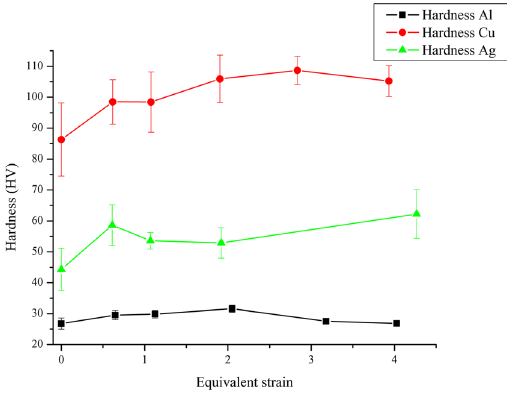
Figure 5. Hardness decay after CT rolled materials removal from LN